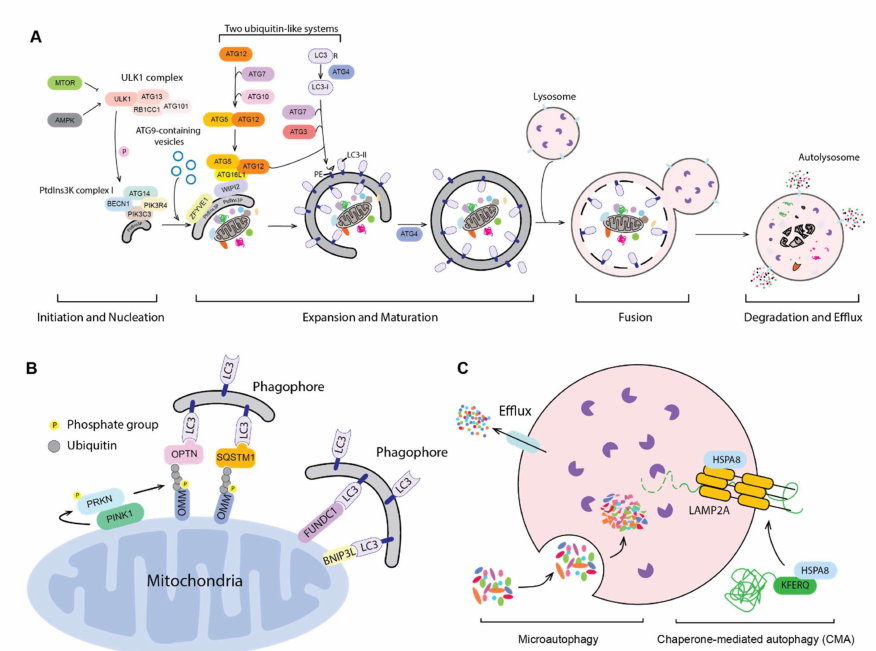
Figure 1. Three types of autophagy. ( A ) The mechanism of macroautophagy. Upon induction, the phagophore nucleates and expands to sequester cytoplasmic substrates randomly or selectively. Upon completion, the phagophore closes and forms a double-membrane autophagosome, which fuses with an endosome (not shown) and/or a lysosome; the autophagic cargos are degraded and the breakdown products are released back into the cytosol. The sequence shown for the LC3B C terminus is for the mouse protein. ( B ) PINK1- and PRKN-mediated and receptor-mediated mitophagy. Upon mitochondrial damage, PINK1 recruits and phosphorylates PRKN on the outer mitochondrial membrane (OMM). PRKN mediated the ubiquitination of OMM proteins, which then bind to autophagy receptors, targeting the mitochondria to a phagophore via interaction with an Atg8-family protein. Additionally, OMM proteins such as FUNDC1 and BNIP3L can serve as the mitophagy receptors. ( C ) Microautophagy and chaperone-mediated autophagy (CMA). During microautophagy, the lysosome membrane rearranges and forms a lumenal vesicle-containing autophagic substrates, which will be degraded within the lysosome. CMA starts from the recognition of a KFERQ-like motif in the substrate protein by HSPA8. HSPA8 facilitates the transport of substrates into the lysosome through the action of LAMP2A and lumenal